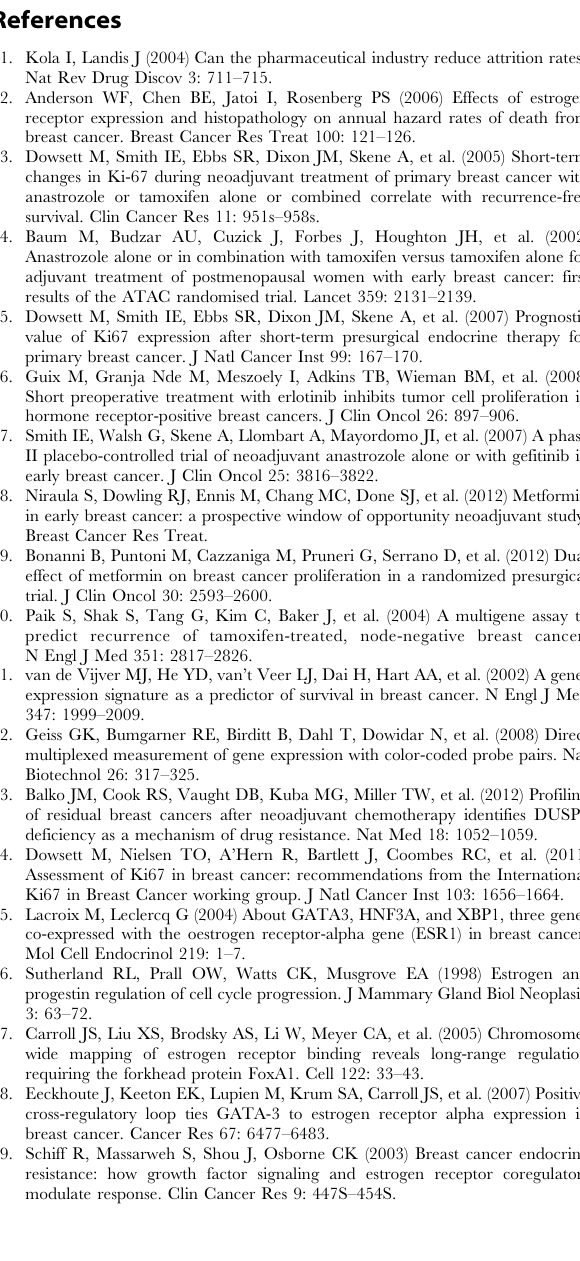
Table S4 Oligonucleotide primer sequences used for